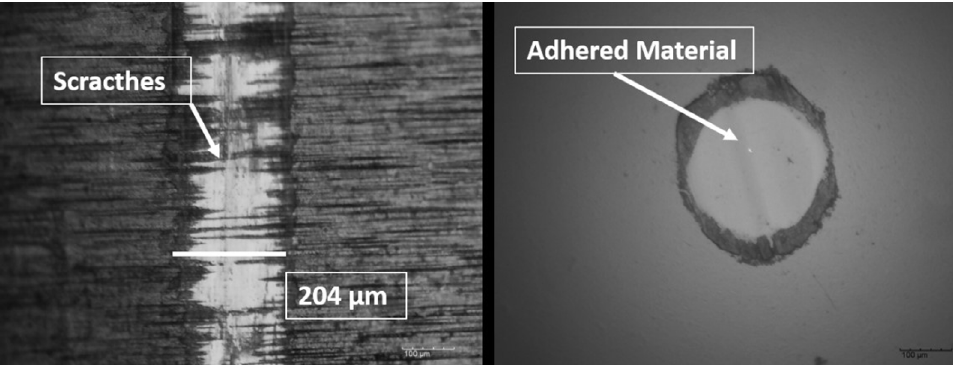
Figure 8. Worn track for the Ni-P 500-1 condition: a) wear pattern; b) counter-face